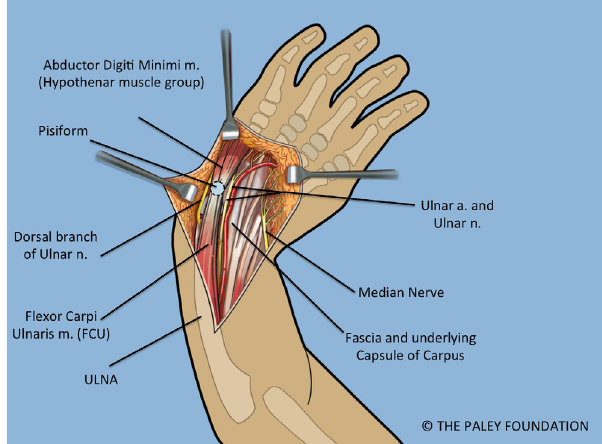
Figure 3. Volar forearm and wrist exposure after volar fasciotomy, showing the ulnar and median nerves, and the flexor tendons. Note the dorsal cutaneous branch of the ulnar nerve passes dorsal to the FCU.